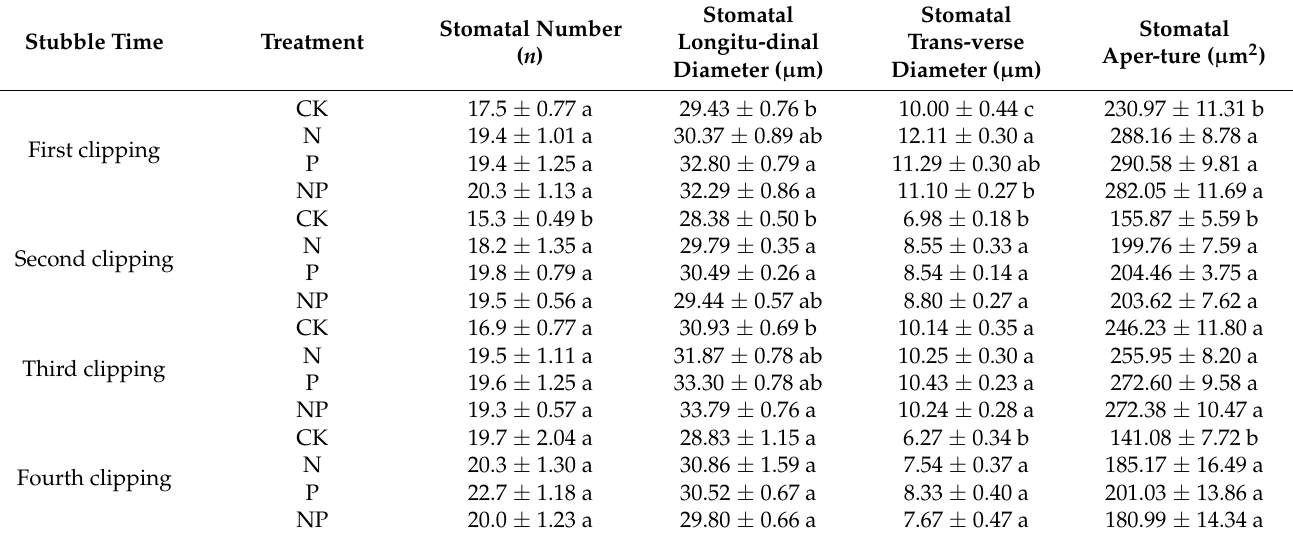
Figure 4. Leaf stomatal images of alfalfa leaves in the third clipping with different nitrogen and phosphorus. ( A ) shows CK, ( B ) shows N, ( C ) shows P and ( D ) shows NP. The magnification of stomatal images is 100. Table 3. Changes of stomatal density of alfalfa leaves under nitrogen and phosphorus